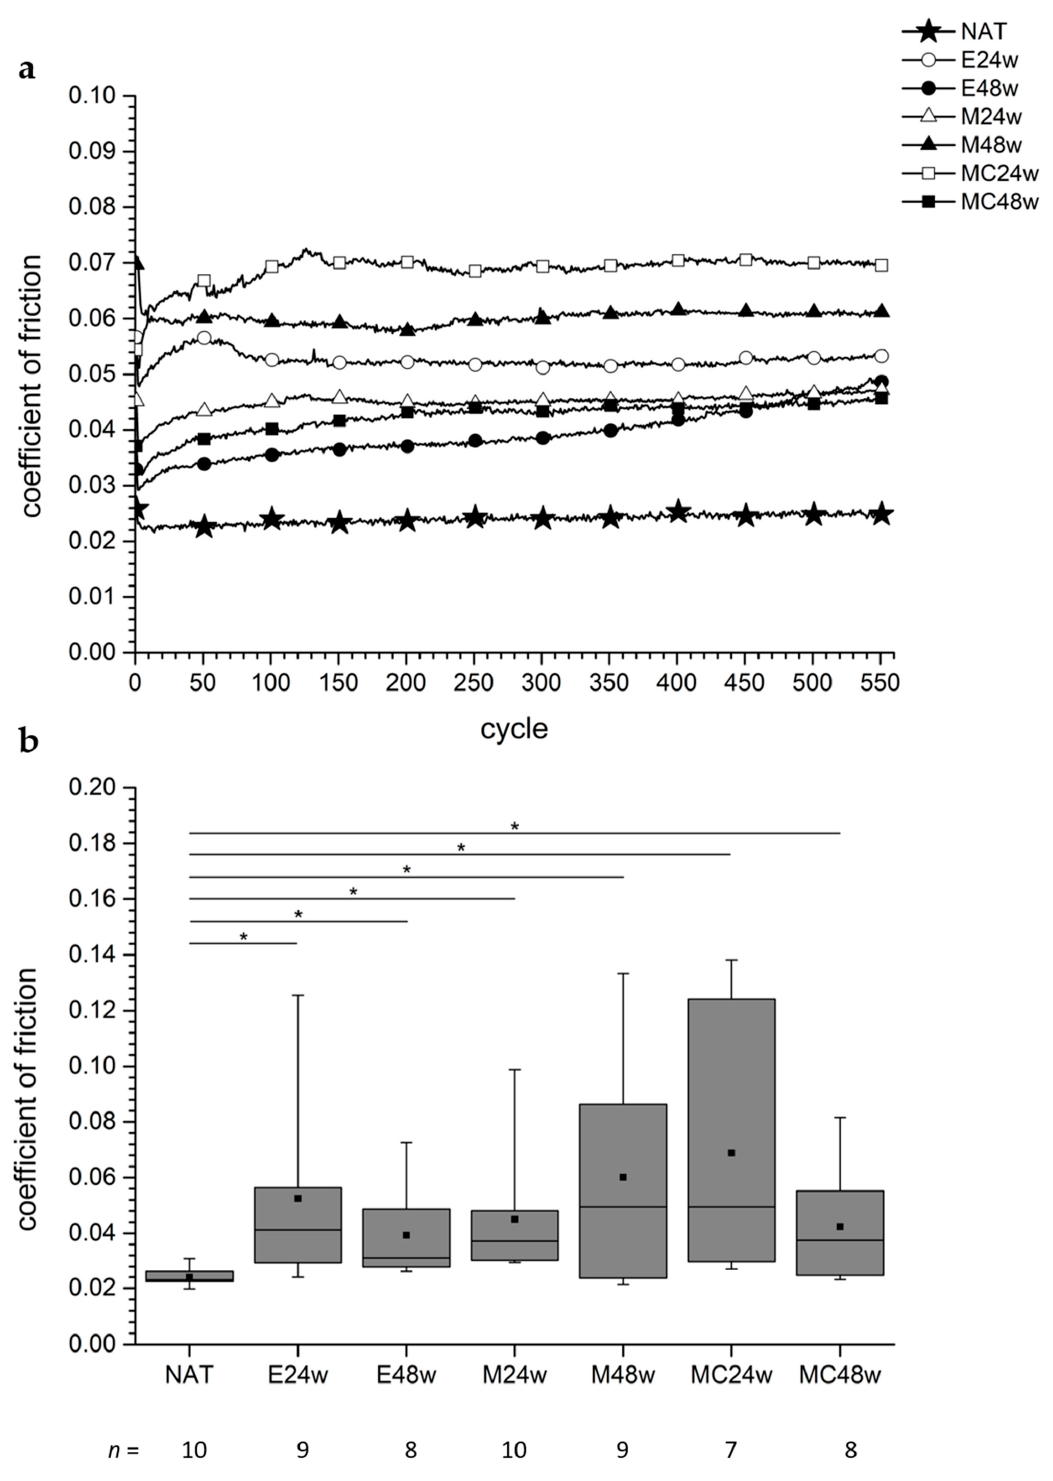
Figure 2. The figure shows the CoFs of the specimens from the defect areas. ( a ) The CoF of the specimens from the NAT group reveals a low and constant value during the observation time of the examinations of approximately 1 h (554 cycles). The regenerated tissues deliver higher CoFs with a mainly asymptotic progression. For the sample size per group, see figure ( b ). ( b ) All CoFs of the regenerated tissue from the operated groups are significantly higher than those of the AC from the NAT group. The * shows the significance between the two